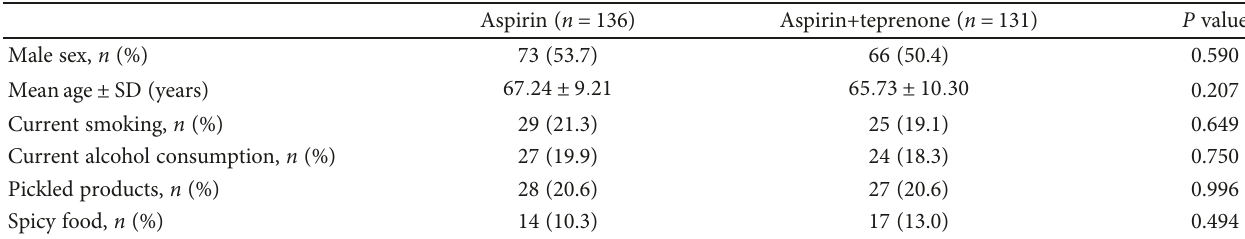
Table 1: Baseline characteristics of patients.